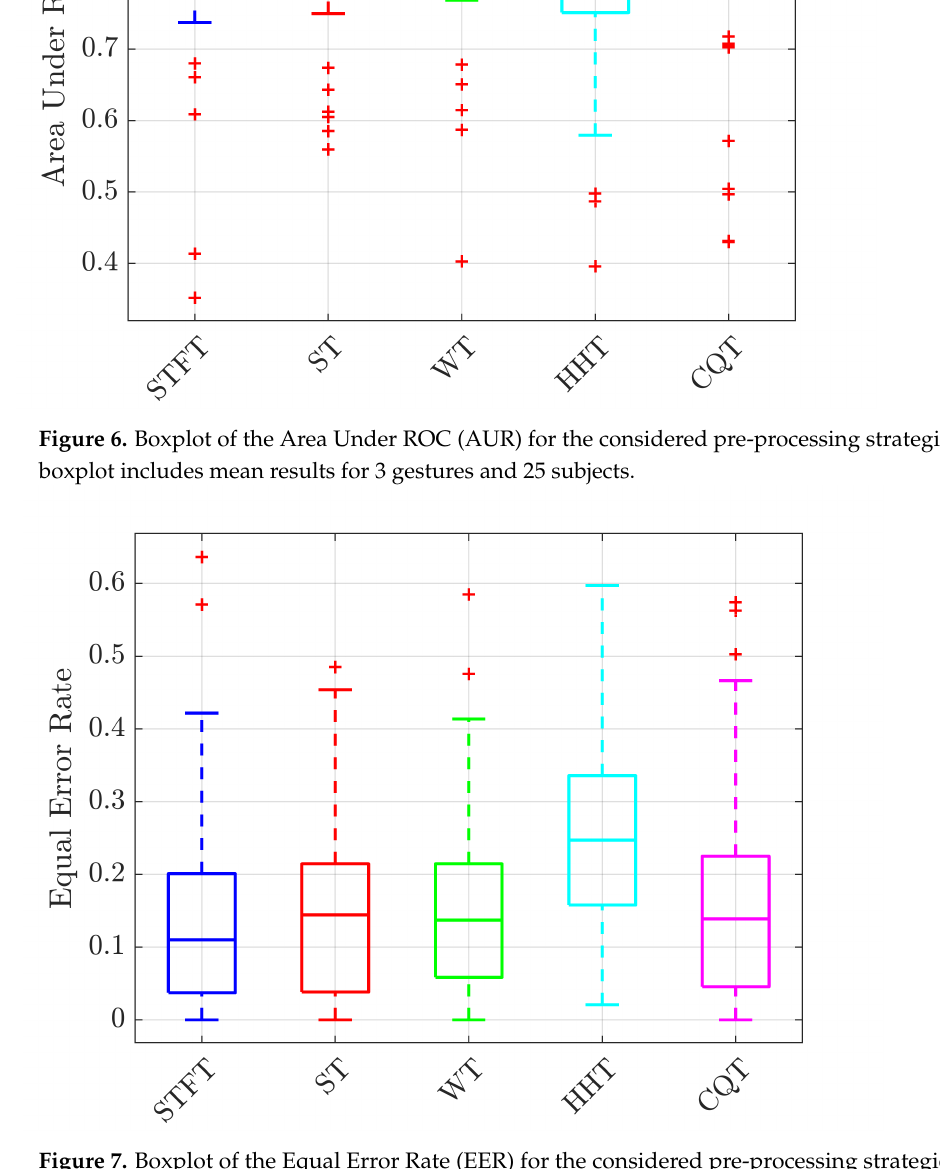
Figure 7. Boxplot of the Equal Error Rate (EER) for the considered pre-processing strategies. Each boxplot includes mean results for 3 gestures and 25